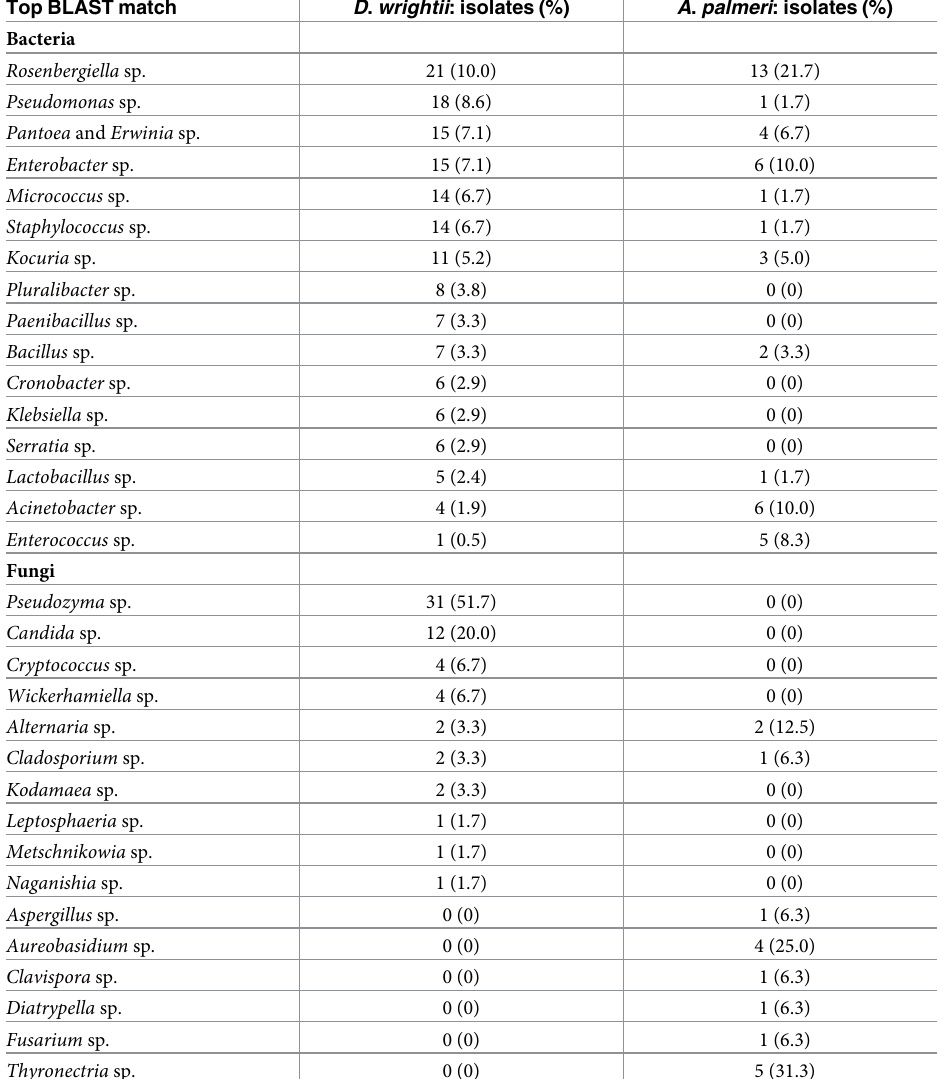
Table 2. Top BLAST matches (genera) for the most common bacteria and all fungi isolated from nectar of D . wrightii and A . palmeri (see S1 Table for full list and details). Taxa are presented in decreasing order of abundance as isolated from D . wrightii . (%) = isolates relative to total isolates of bacteria (above) or fungi